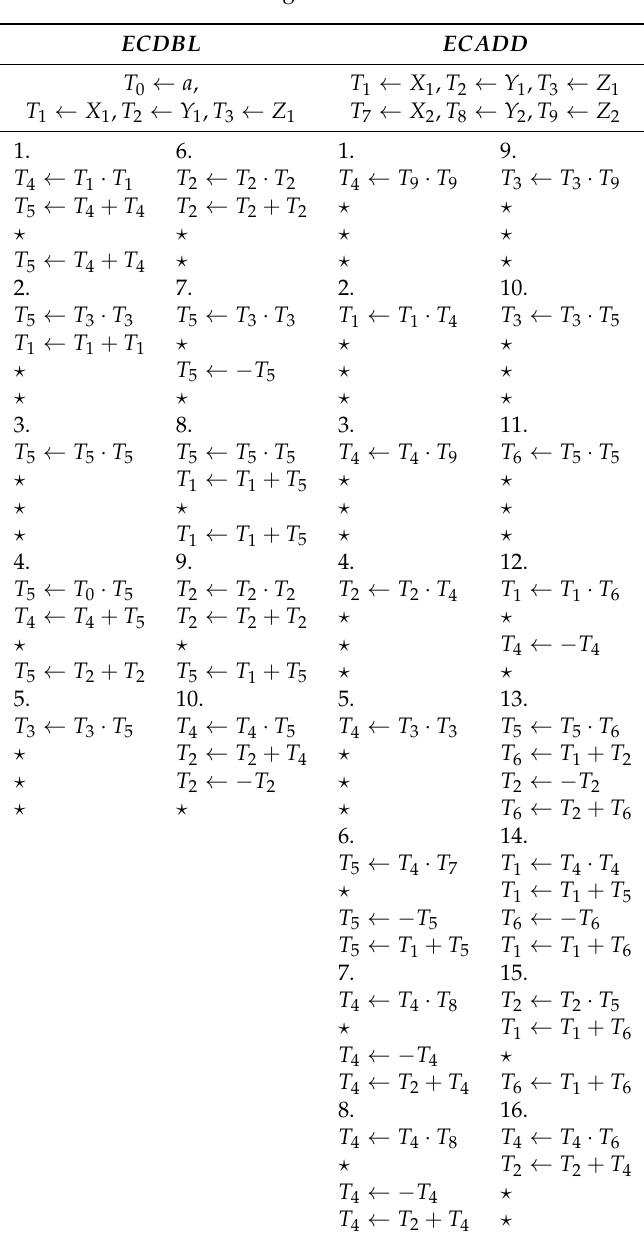
Table 3. Existing atomic block